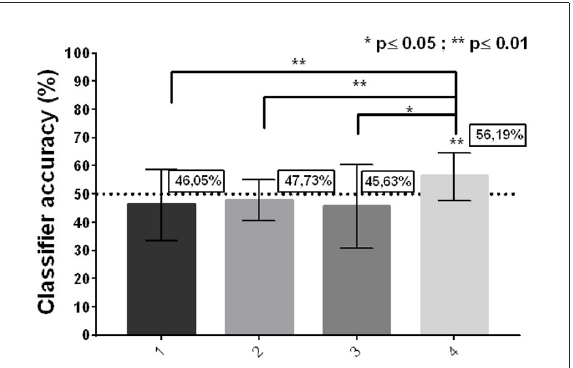
FIGURE2 Pre-processing of the functional images for online subject-independent classification. A structural imaging session and a Dummy functional imaging session are performed prior to the functional imaging session of the online classification. The average of the Dummy functional images is co-registered with the structural neuroimaging to obtain the normalization parameters that will be used in the abbreviated pre-processing of the functional neuroimages used in the online classification.